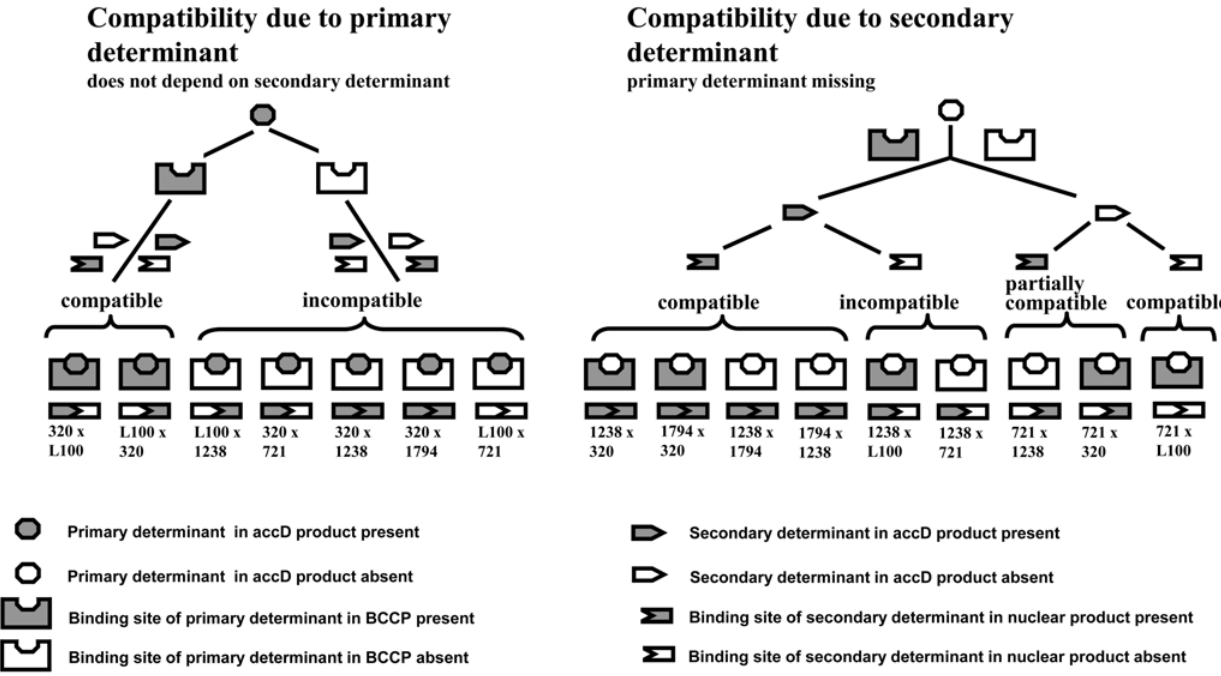
Fig 4. Presumable sheme of compatible and incompatible combinations of molecular determinants in the plastid accD and nuclear loci. Partially compatible combinations display decreased pollen fertility but without lethal effects